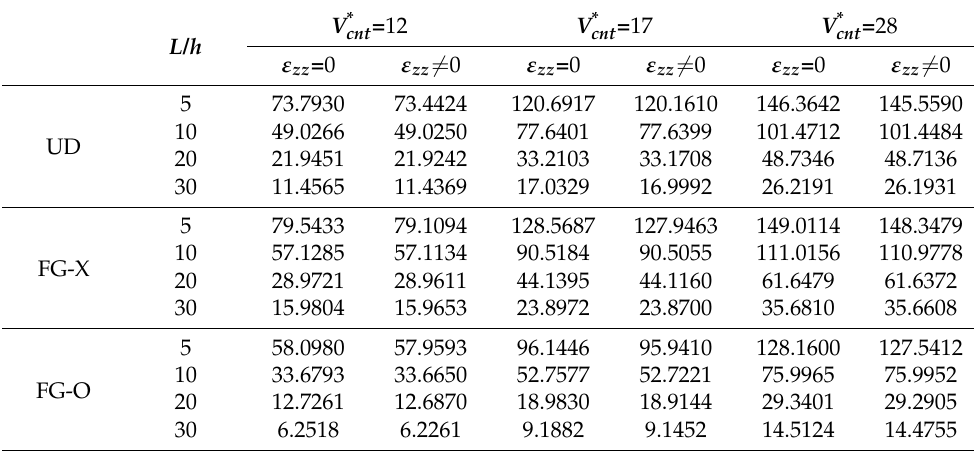
Table 5. Effect of thickness ratio on the buckling load of a single layer CNTRC curved beam α = π T = 300